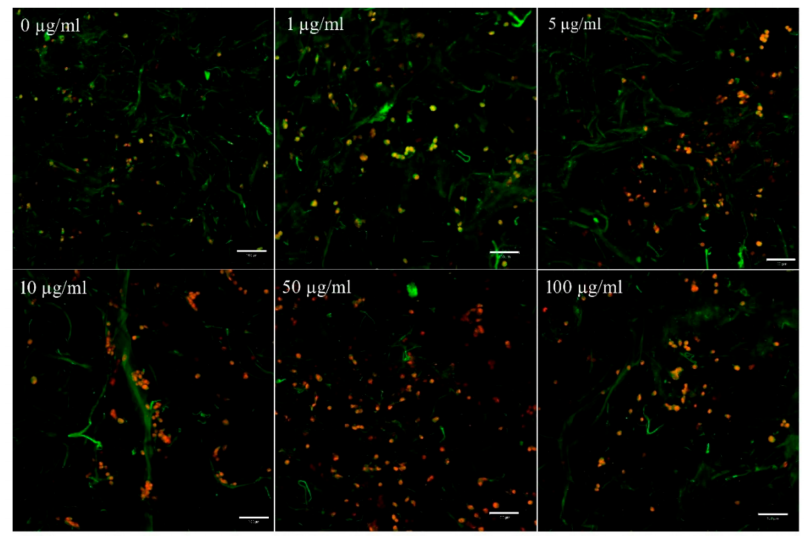
Figure 7. Confocal microscopy imaging of cell adhesion of 3T3 fibroblasts on Col/Chit scaffolds on day 1. Staining of cell membranes with the fluorescent probe 3,3 (cid:48) -diethyloxacarbocyanine iodide DiOC3(6) (green) and cell nuclei with propidium iodide (red) was used to detect the adhesion of cells on the scaffolds with different concentrations of FGF2-STAB ® , a scale bar is 100 µ m. Slight green autofluorescence of the Col/Chit scaffold is present.